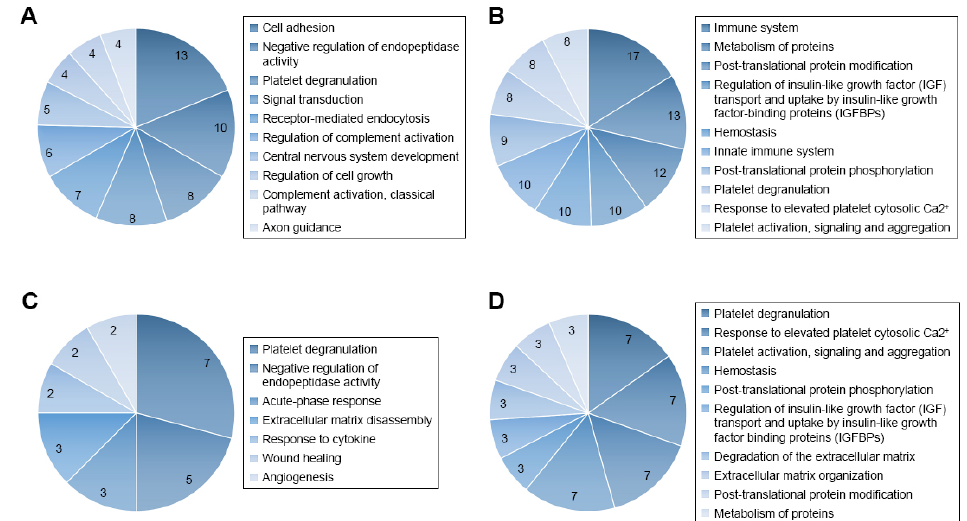
Figure 1. Gene ontology (GO) and REACTOME pathway analysis of quantified proteins. ( A ) Top 10 biological processes obtained from GO analysis of all differentially expressed proteins. ( B ) Top 10 pathways obtained from REACTOME pathway analysis of all differentially expressed proteins. ( C ) Biological processes obtained from GO analysis of cluster 1 proteins. ( D ) Top 10 pathways obtained from REACTOME pathway analysis of cluster 1 proteins. Figure reproduced from Reference [35] with permission from Dove Medical Press, the original publisher.